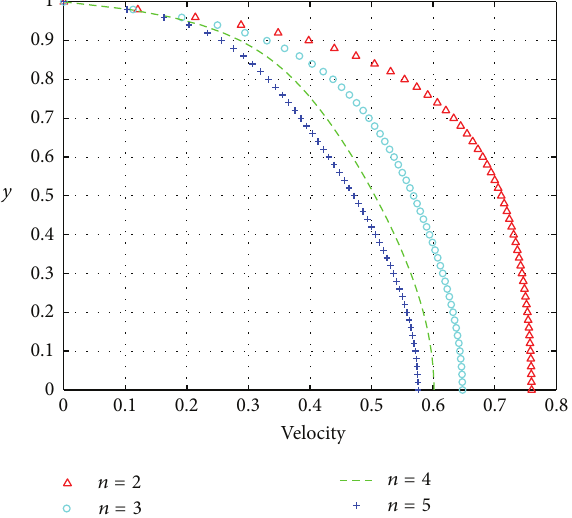
Figure 9: Variation of wall shear stress with hematocrit shape; 𝑡 = 50 .